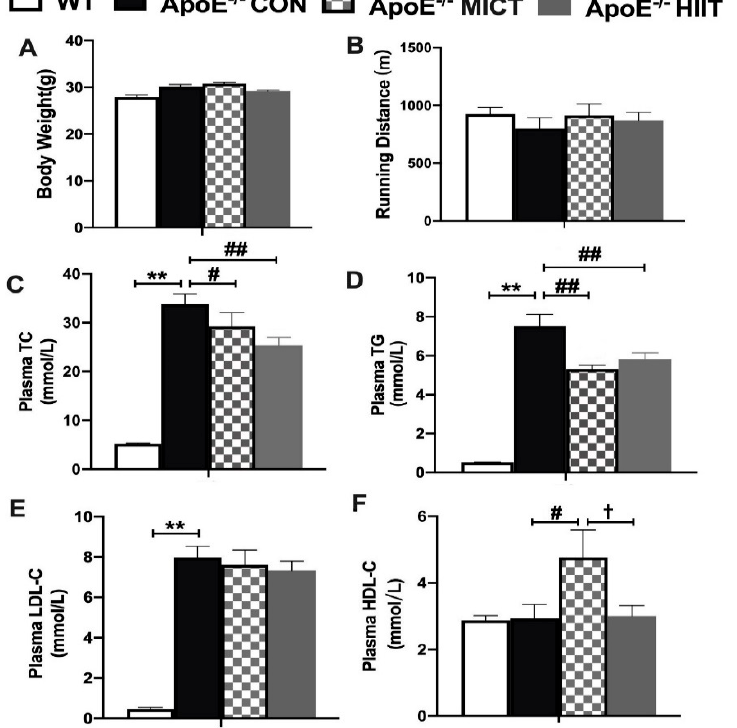
Figure 1. Effects of HIIT and MICT on body weight ( A ), running distance ( B ), and plasma lipid profiles ( C – F ) in WT mice and ApoE KO mice on HFD. Values are displayed as the mean ± SEM (n = 10/group). ** p < 0.01 vs. WT; # p < 0.05 vs. ApoE -/- CON; ## p < 0.01 vs. ApoE -/- CON; † p < 0.05 vs. ApoE -/- MICT.